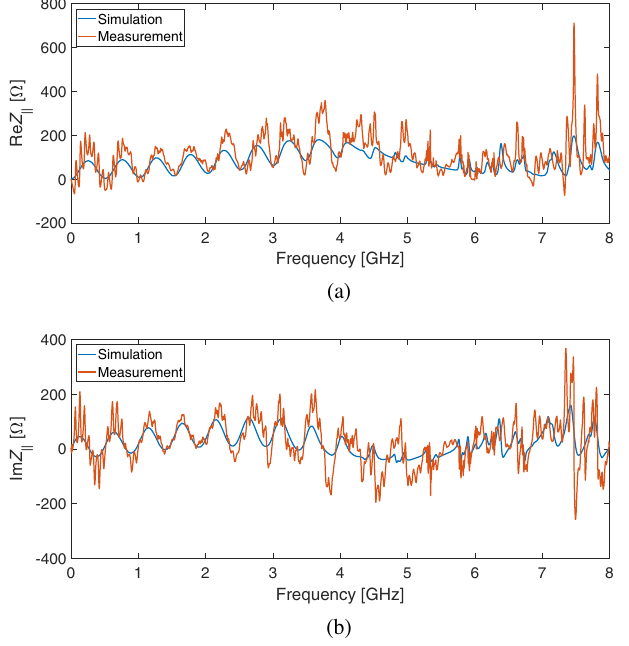
FIG. 12. The real part (a) and imaginary part (b) of the longitudinal impedance measured by the coaxial method, and compared with simulations.